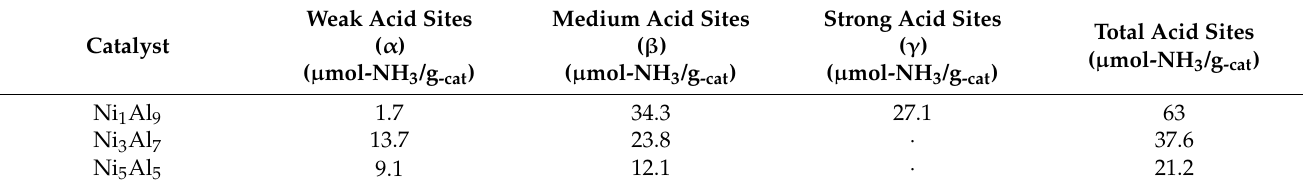
Figure 5. NH 3 temperature-programmed desorption (NH 3 -TPD) profiles of the NiAl 2 O 4 catalysts with various Ni/Al ratios. Table 4. Acid site densities for the NiAl 2 O 4 catalysts with various Ni/Al ratios determined from the NH 3 temperature- programmed desorption (NH 3 -TPD)